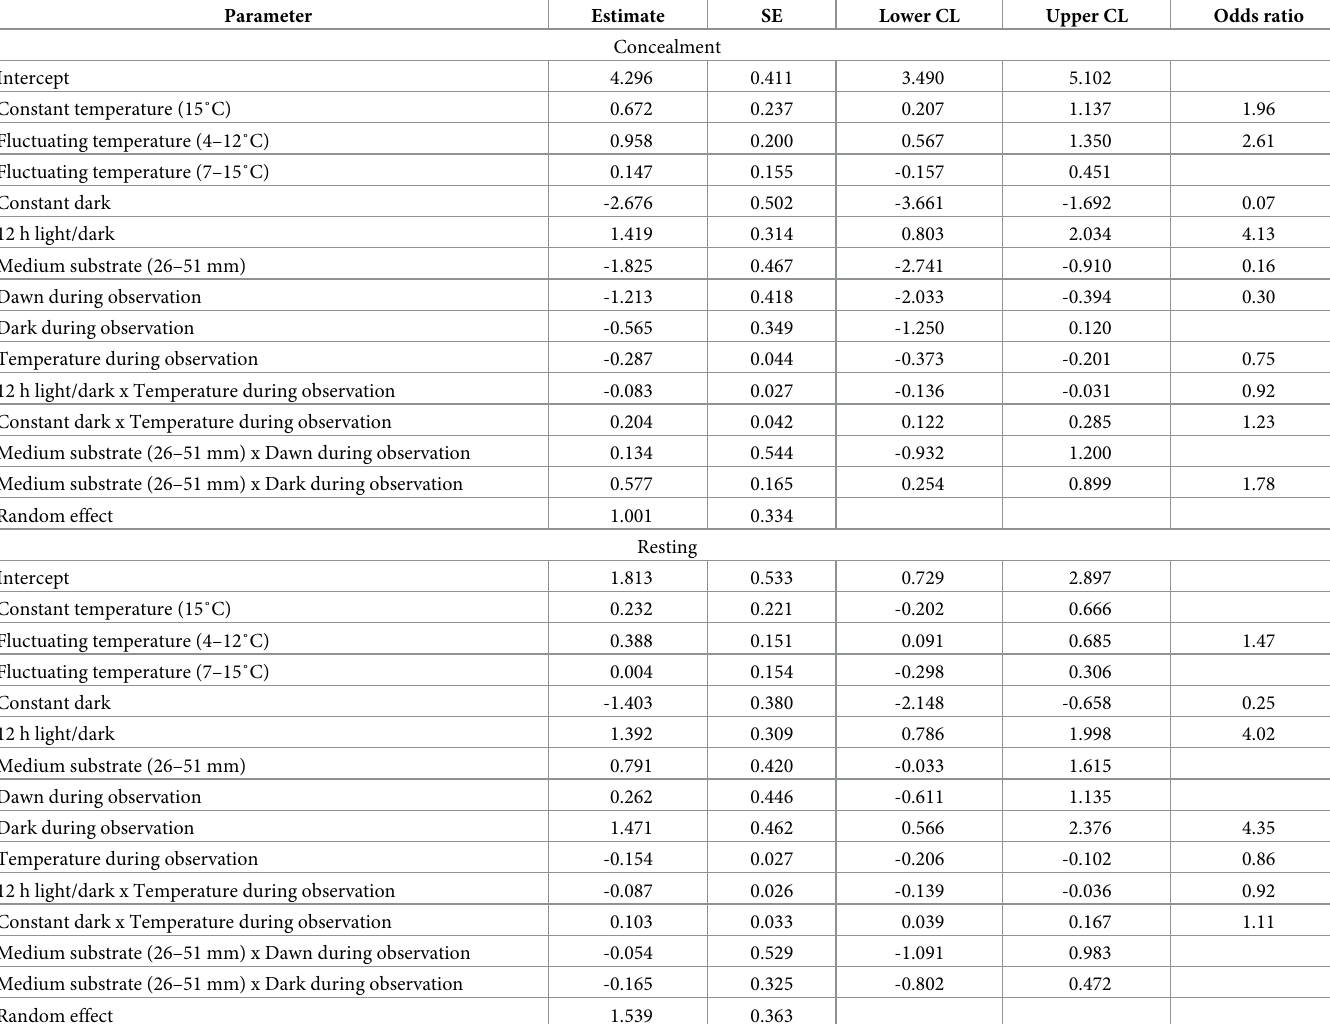
Table 2. Parameter estimates, Standard Errors (SE), upper and lower 95% Confidence Limits (CL) and odds ratios from the final multinomial logistic regression model of wild bull trout